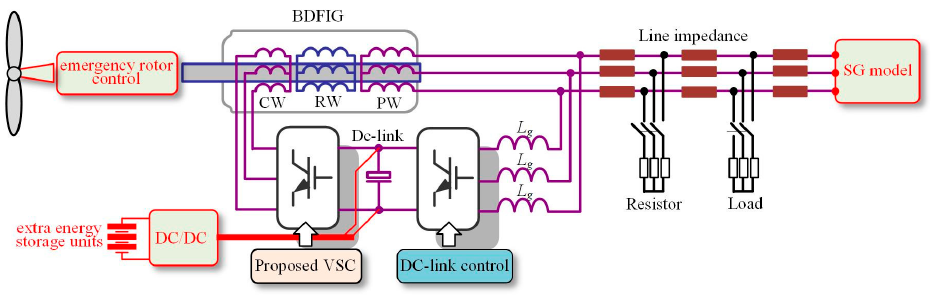
Figure 6. The system model of BDFIG.